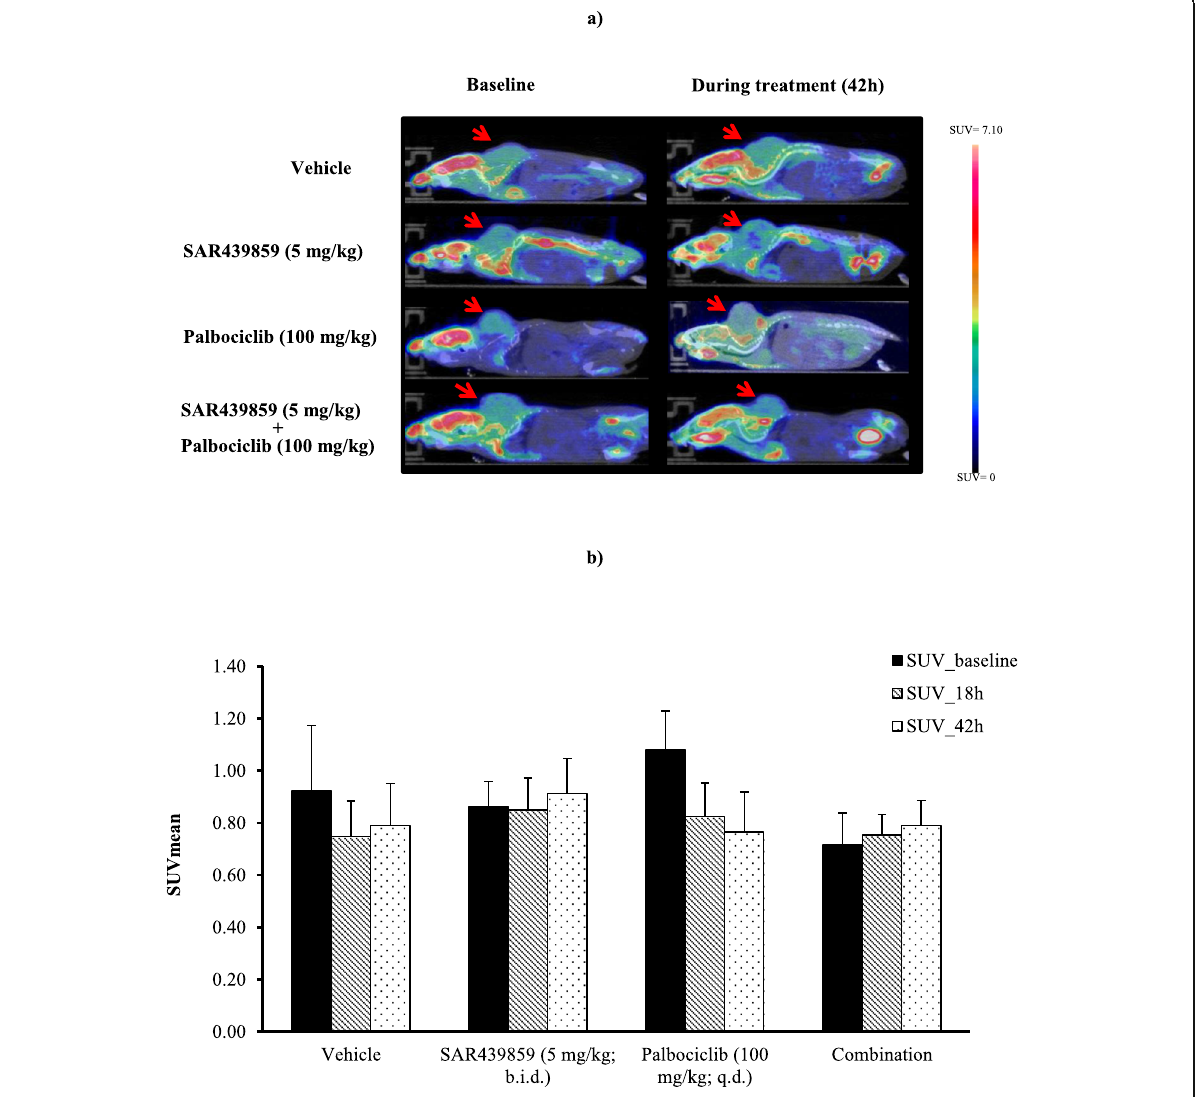
Fig. 3 a Representative FDG-PET images of mice at baseline and during drug exposure. b Temporal PET-FDG quantification in MCF7-Y537S tumor upon treatment with SAR439859 alone or in combination with palbociclib for 3 days. Differences among groups were not statistically